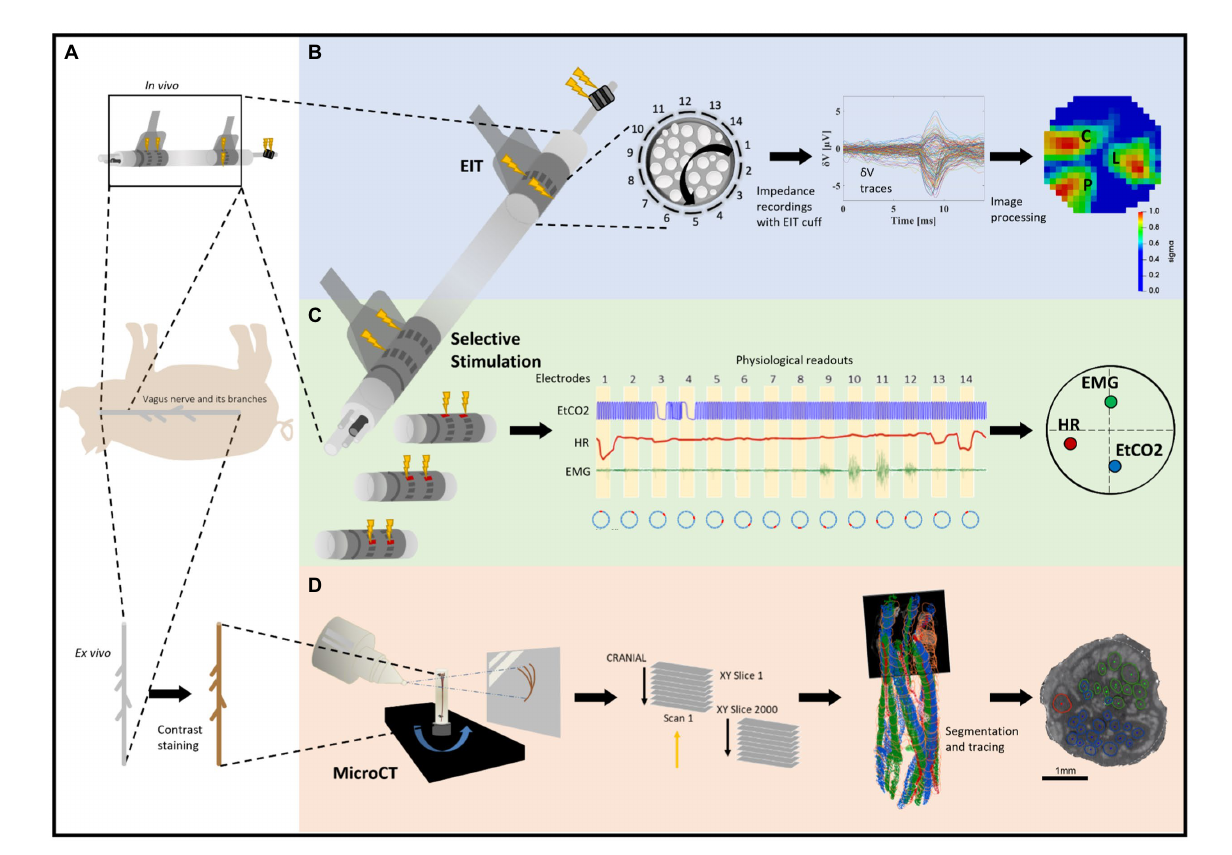
FIGURE 1 Experimental design for pig cervical vagus nerve imaging with Electrical Impedance Tomography (EIT), selective stimulation (SS), and micro-computed tomography (microCT). (A) In vivo experiment in pigs with EIT and SS cuffs placed around the left vagus nerve ( N = 4) followed by dissection of the nerve from cervical level to below the pulmonary branches, including the cardiac and laryngeal branches, for ex vivo microCT. One additional bipolar cuff is placed around the recurrent laryngeal (RL) branch to evoke action potentials. (B) Identification of the areas responsible for cardiac (C), pulmonary (P), and laryngeal (L) functions in the cervical vagus nerve with EIT. The color scale is arbitrary units (Z score of relative change in the modulus of the impedance). (C) Selective stimulation through individual electrode pairs applied sequentially around the circumference of the cuff (pairs 1–14) with resulting physiological changes, such as heart rate (HR, red, cardiac), electromyography (EMG, green, recurrent laryngeal) and end- tidal carbon dioxide (EtCO2, blue, pulmonary), to determine cross-sectional location of the fascicular groups responsible for the respective functions. (D) MicroCT scanning of the full dissected vagus nerve followed by segmentation and tracing from the point of organ-specific branching up to the cervical level of cuff placement to identify the location of organ-specific fiber-containing fascicles (cardiac, red; laryngeal, green; and pulmonary,